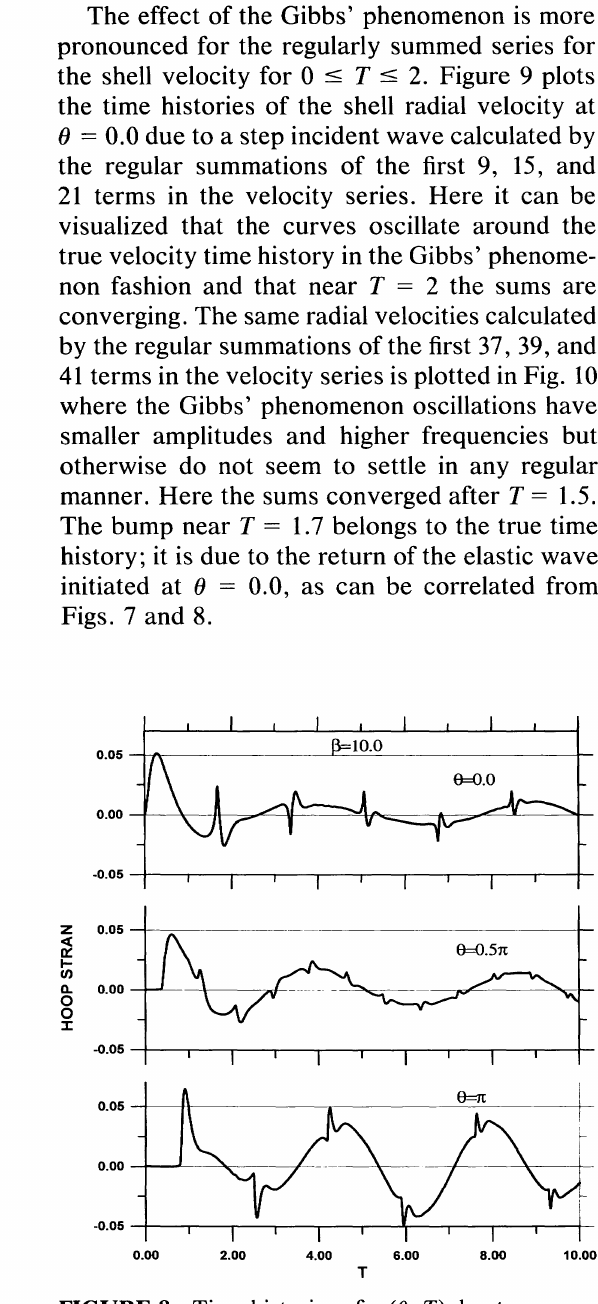
FIGURE 8 Time histories of 81(0, T) due to a expo nentially decaying incident